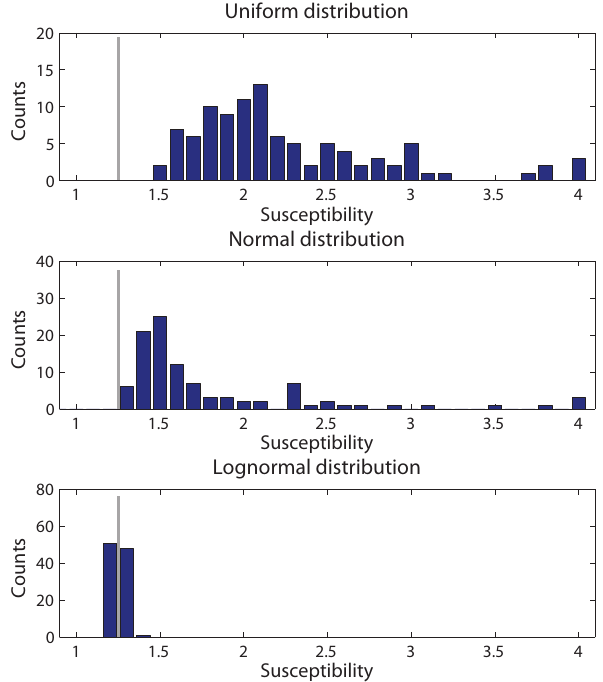
Fig. A1. Histogram of susceptibility estimates using TLD for three different distributions of data: uniform (top), normal (middle), and lognormal (bottom). The histograms are based on 100 estimates cal- culated from 100 different samples of the same underlying distribu- tion. The gray line at 1.25 shows the value of β in the underlying relationship R = aN − β